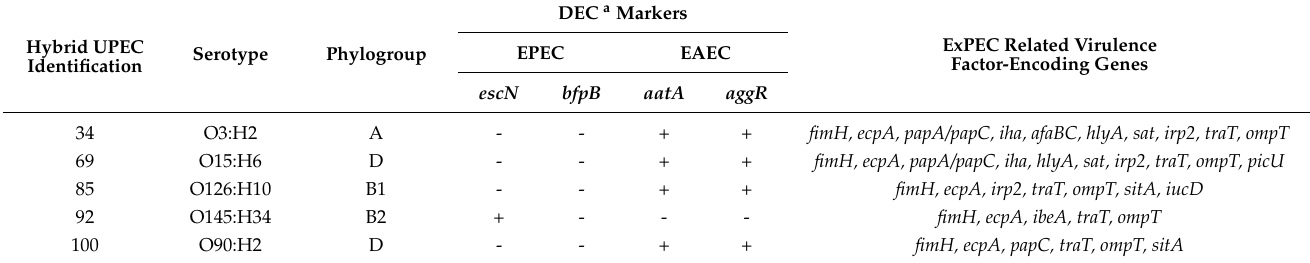
Table 2. Serotype, E. coli phylogroup classification, and molecular characteristics of the hybrid